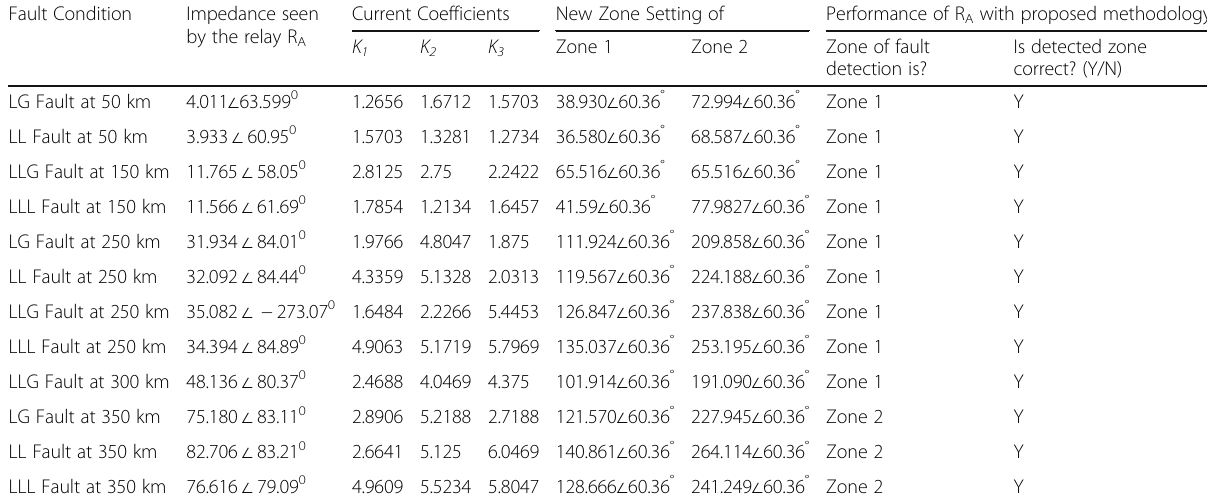
Table 7 Performance of the distance relay R A with PAZSD methodology for different faults with FR = 0.2 Ω at different distances Fault Condition